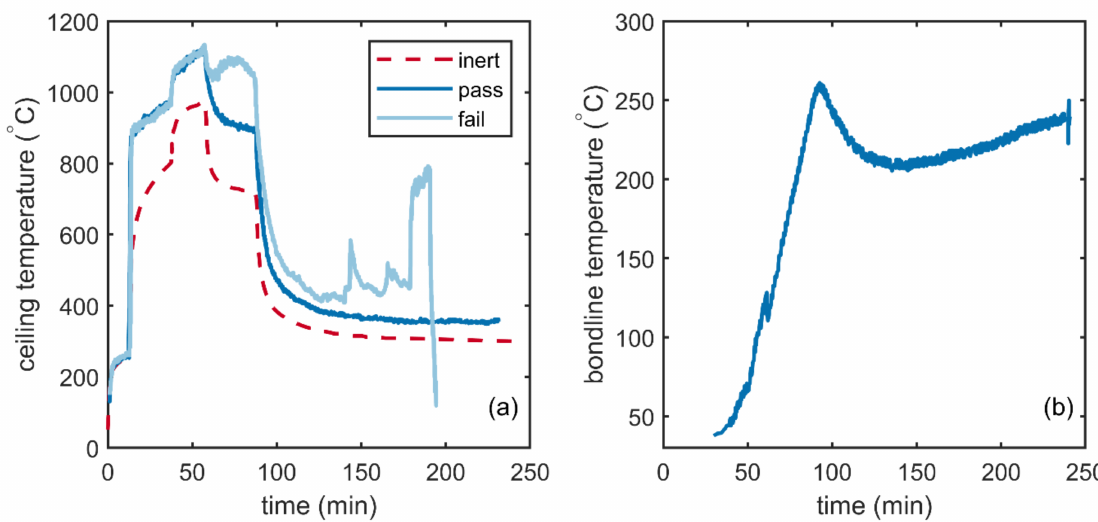
Figure 1. ( a ) Temperature profile specified in the PRG-320 test (labeled inert) with corresponding temperature profiles for cross laminated timber (CLT) with adhesives that passed and failed the test. ( b ) Temperature profile at the first bondline for an adhesive that passed the PRG-320 test. Data replotted from